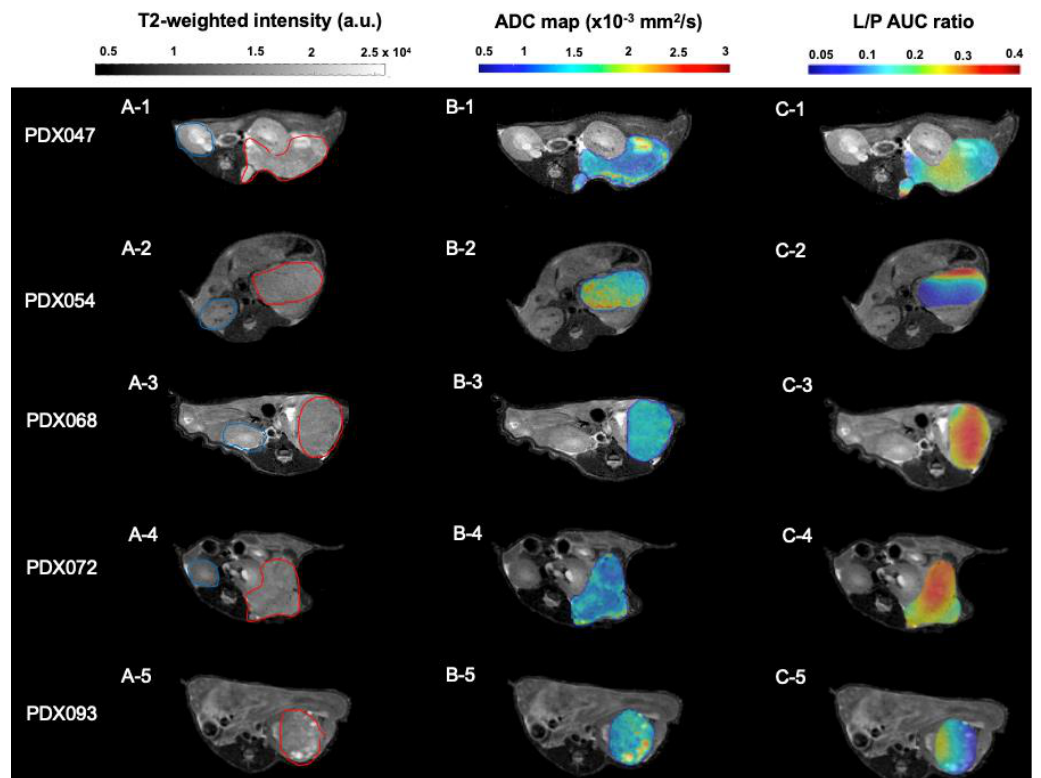
Figure 1. ( A1 – A5 ) Representative T2-weighted MR images of PDX implanted under the murine renal capsule. Blue and red lines were drawn along the borders of the contralateral kidney and tumor, respectively. Images show intra-tumoral heterogeneity in some PDX, especially hyperintense components. ( B1 – B5 ) Representative ADC maps overlaid on the T2-weighted images of PDX tumors. ADC images highlight differences in water diffusion among PDX with intra-tumoral heterogeneity in most tumors. ( C1 – C5 ) Representative L/P AUC ratio maps overlaid on the T2-weighted images of PDX tumors, reflecting intra-tumoral variation in glycolytic metabolism in all tumors. a.u.= arbitrary units; AUC = area under the